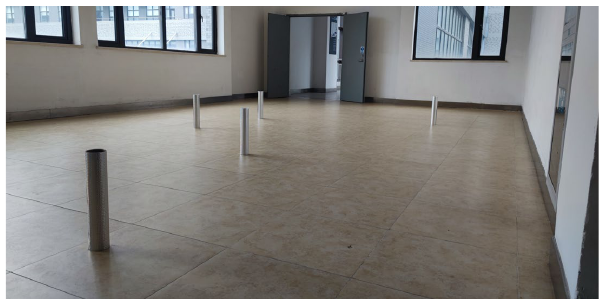
Figure 7. The experimental layout environment of 5x initialization reflectors. Localization data are obtained at nine different locations. The position error and orientation angle error obtained in the three cases are shown in Figure 8. It can be seen that the localization accuracy of the initial point is not necessarily related to the number of initialization reflectors, and it is not true that the more the number of reflectors, the higher the localization accuracy of the initial point. The experimental results show that the maximum X-direction localization error of the initial position is 18.4 mm, the maxi- mum Y-direction localization error is 8.1 mm, and the maximum angle error is 1.29 deg, which meets the localization accuracy requirements of industrial application environ- ment; the localization error statistics in X and Y directions are shown in Tables 1 and 2, and the angle error statistics are shown in Table 3. The optimal triangular positioning method based on angle measurement also uses five reflectors to perform static positioning at nine different positions [16]. Tables 4–6 are the comparisons of the positioning method in initialization mode and the optimal trian- gular positioning method in the X-direction positioning error, the Y-direction positioning error, and the orientation error, respectively. The localization method in this study shows more accurate results of the X -direction and angle. It is worth mentioning that even with such high resolution, the maximum noise of 20 mm will be converted to the same amount of variation to LiDAR data and contaminate the localization precision. By applying the